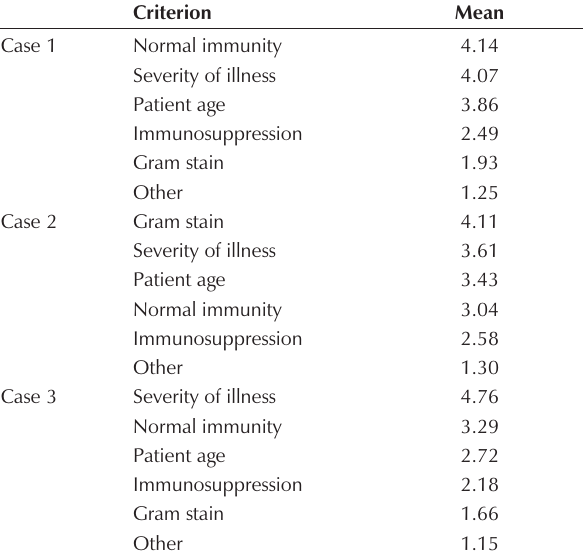
Mean corrected weight assigned to Likert scales of closed-ended questionnaires for a survey of Canadian infectious disease specialists